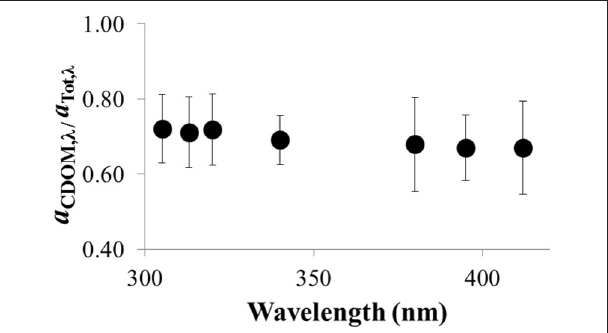
FIGURE 9 | Ratio of of a CDOM , λ /a Tot , λ vs. wavelength in the UV for Lake Erie water (average ± SE, n = 64 water samples collected over the summer in